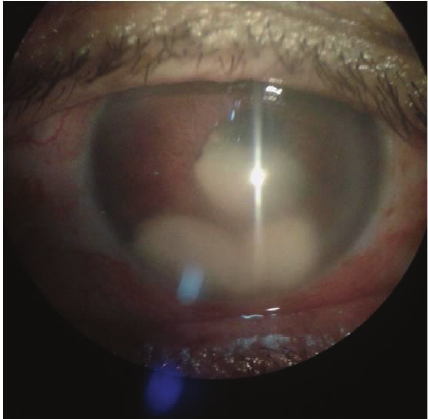
Figure 1: Fluffy white exudates in anterior chamber and surrounding the IOL in capsular bag.